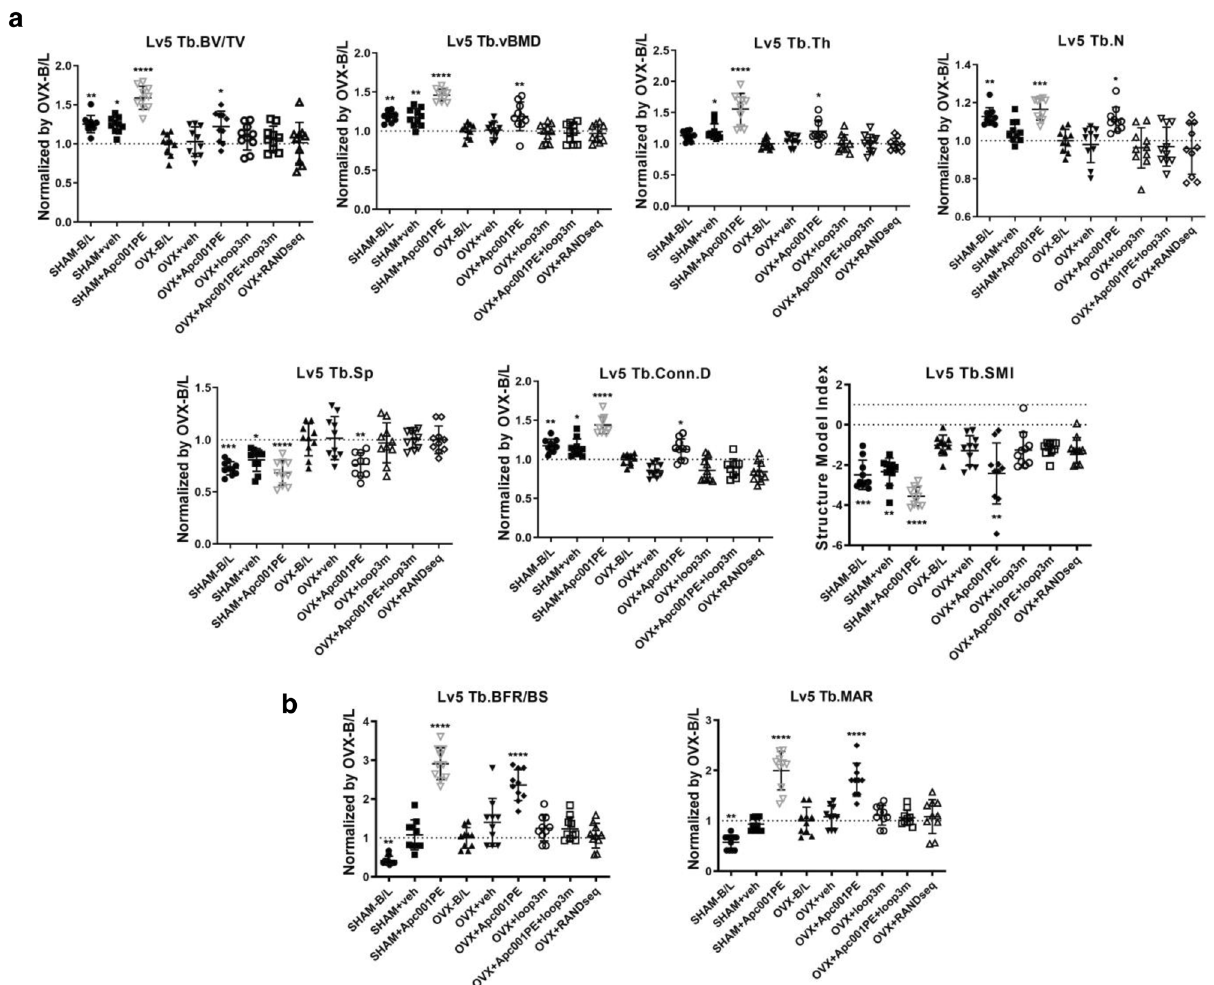
Fig. 8 Determination of whether targeting sclerostin loop3 by the speci fi c in vivo pharmacologic tool Apc001PE could exert bone anabolic potential by neutralizing circulating sclerostin loop3 in ovariectomy-induced (OVX) osteoporotic rats. a Bar charts of the structural parameters from ex vivo micro- CT at the fi fth vertebrae. Tb.BV/TV: p = 0.0086 (SHAM-B/L), p = 0.0138 (SHAM + veh), p < 0.0001 (SHAM + Apc001PE), p = 0.0277 (OVX + Apc001PE); Tb.vBMD: p = 0.0033 (SHAM-B/L), p = 0.0066 (SHAM + veh), p < 0.0001 (SHAM + Apc001PE), p = 0.0028 (OVX + Apc001PE);